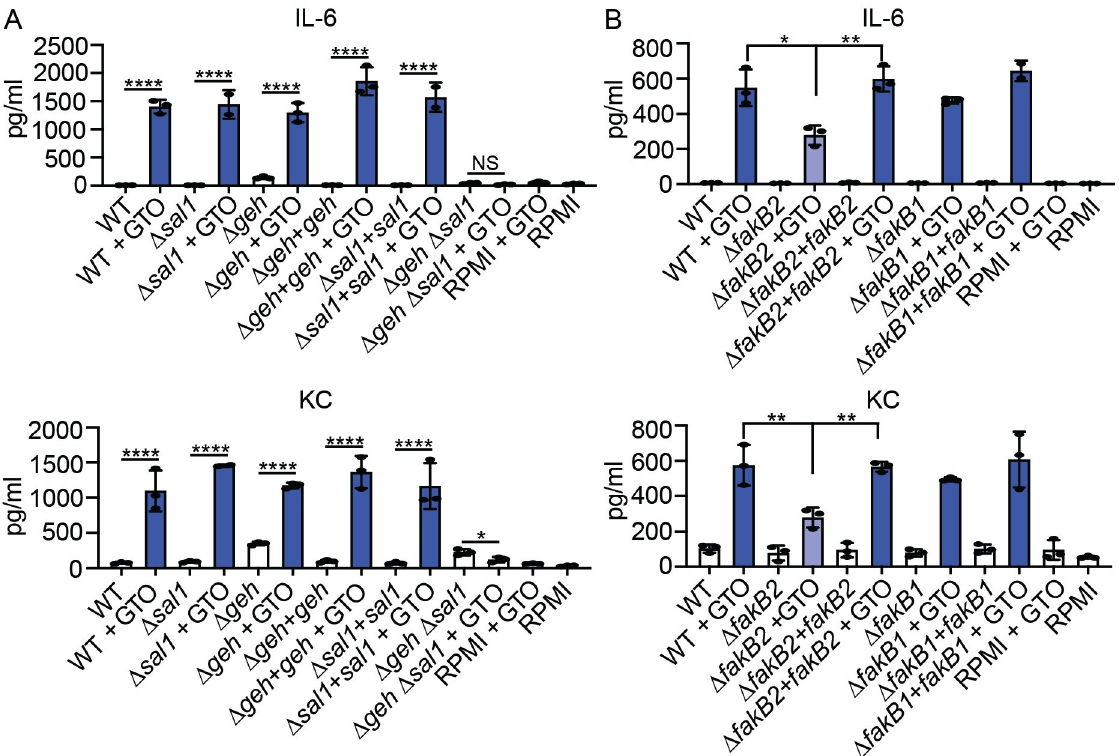
Fig 3. Lipases and FakB2 mediate eFA-based immune cell activation. (A-B) IL-6 and KC (pg/mL) production by BMMs after addition of cell-free supernatant from the indicated S . aureus strains grown in RPMI medium or RPMI medium supplemented with GTO (50 μ M), and media only controls. Graphs display mean +/- SD from one of at least three independent experiments conducted in triplicate. Statistical significance was determined by one-way ANOVA with Tukey’s post hoc test. �� P < 0.01; ���� P < 0.0001.